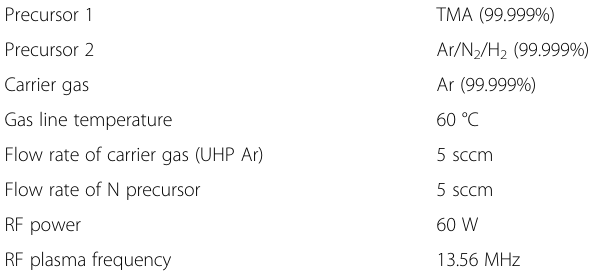
Table 1 Deposition conditions of the AlN films by PEALD Precursor 1